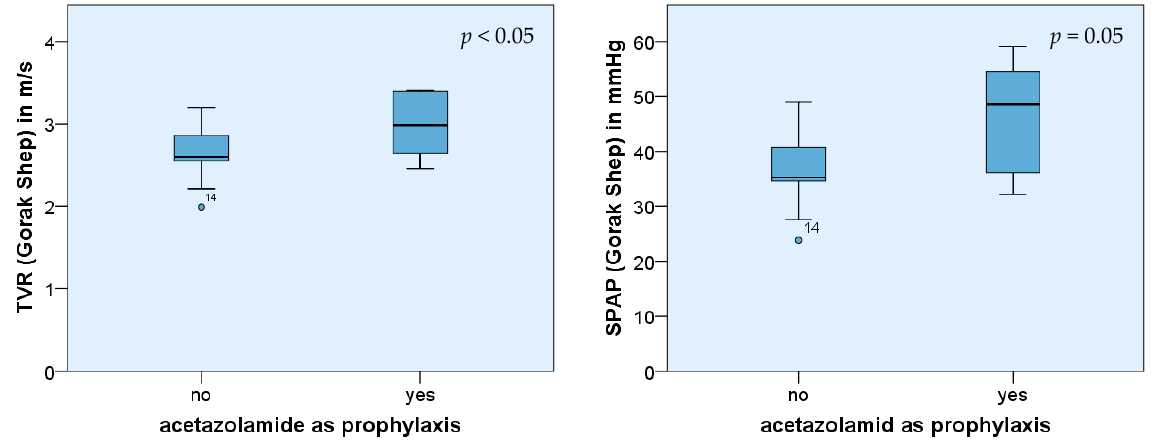
Figure 4. Comparison of mean values and SPAP of TVR in Gorak Shep: subgroup 1 with acetazolamide as prophylaxis (n = 4), subgroup 2 without intake of acetazolamide (n = 21).